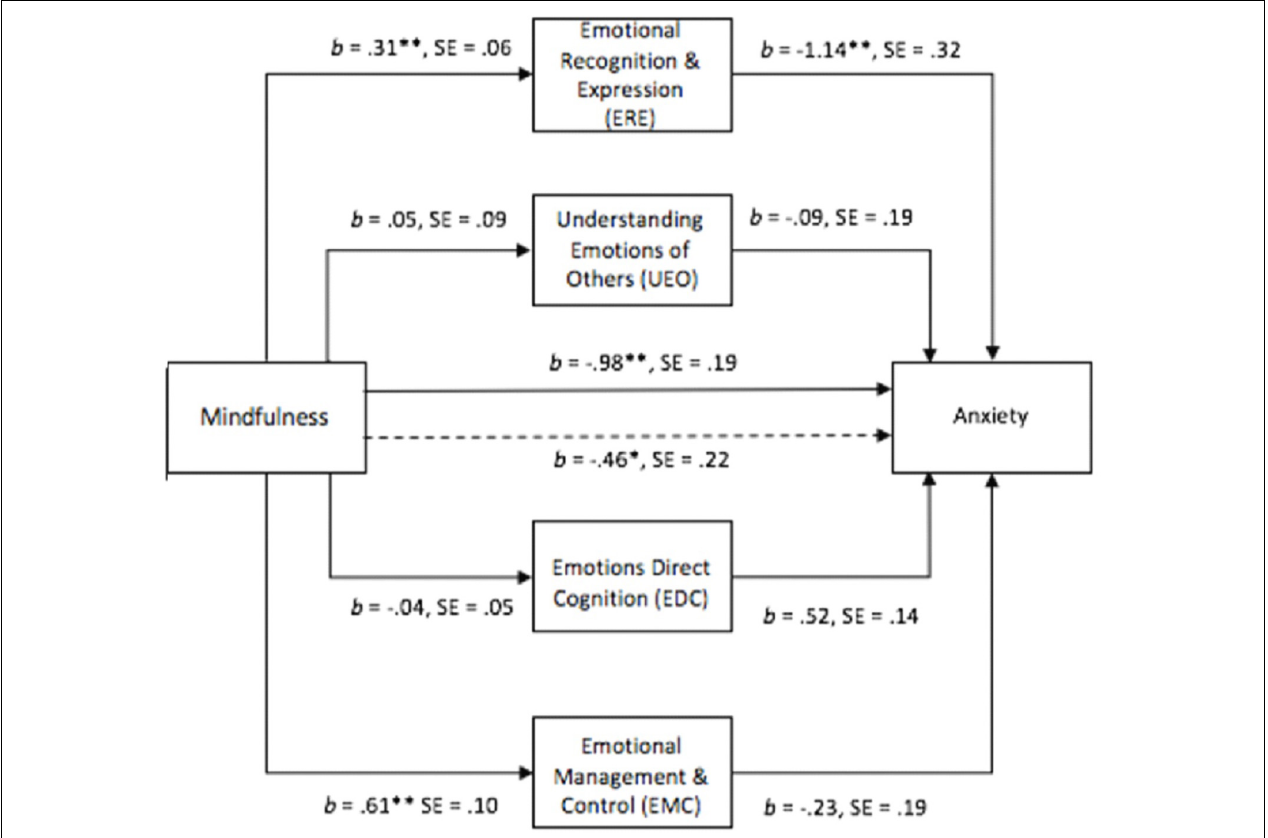
FIGURE 3 | Multiple mediator model examining relation between dispositional mindfulness, subscales of Ei and anxiety. ∗ p < 0.05; ∗∗ p < 0.001. TABLE 3 | Indirect effect and sizes for model pathways between mindfulness and anxiety with EI subscales as the mediating variables. Model pathway Indirect effect